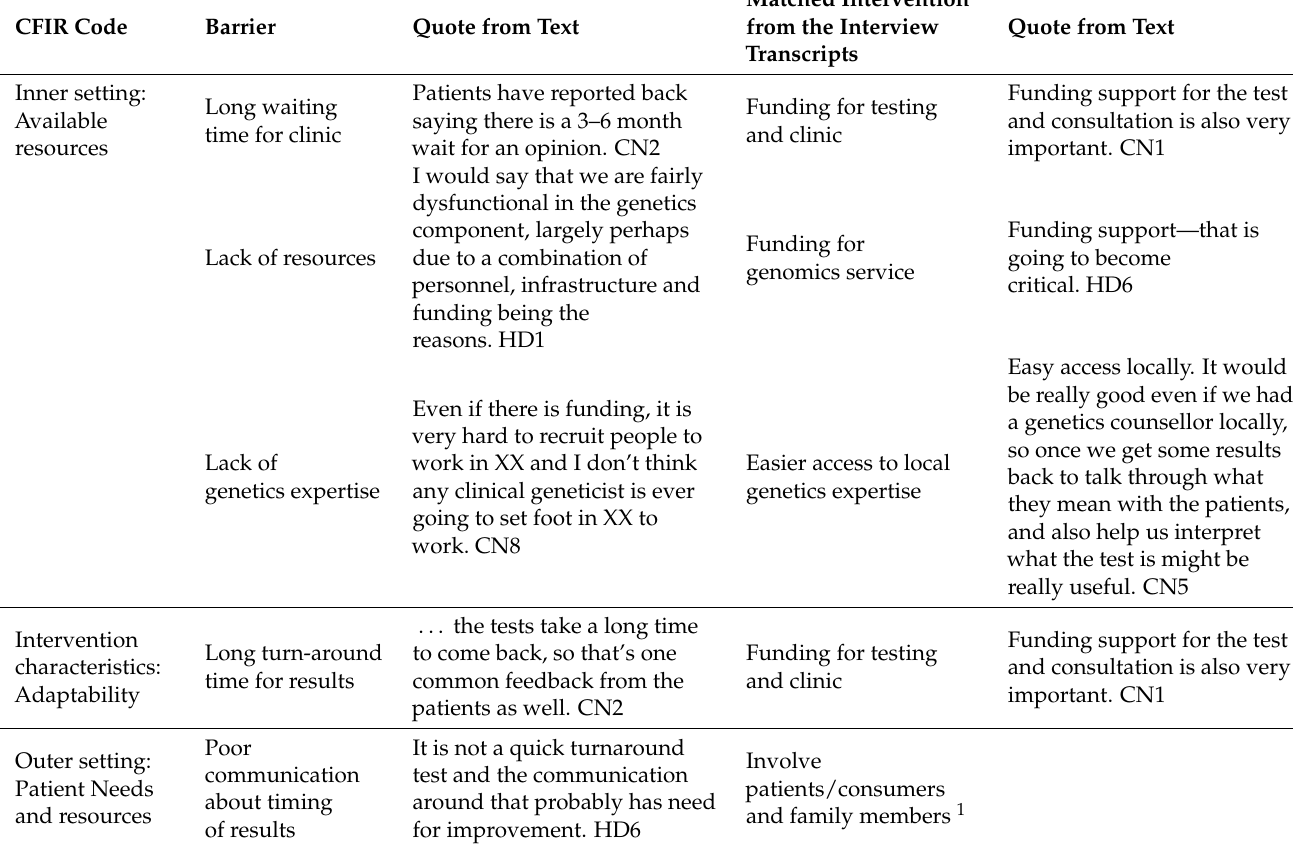
Table 2. Common barriers coded using the CFIR with exemplar quotes and matching